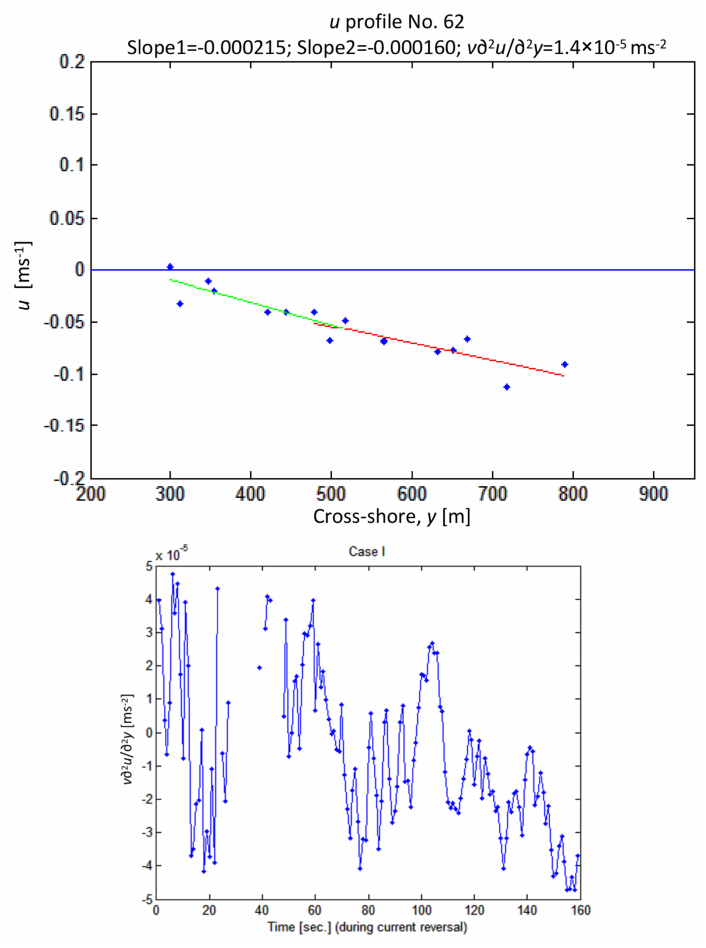
Figure A2. Calculation example of the horizontal dispersion term based on the drifter data of Case I (upper panel). Time series of the horizontal dispersion term of Case I (lower